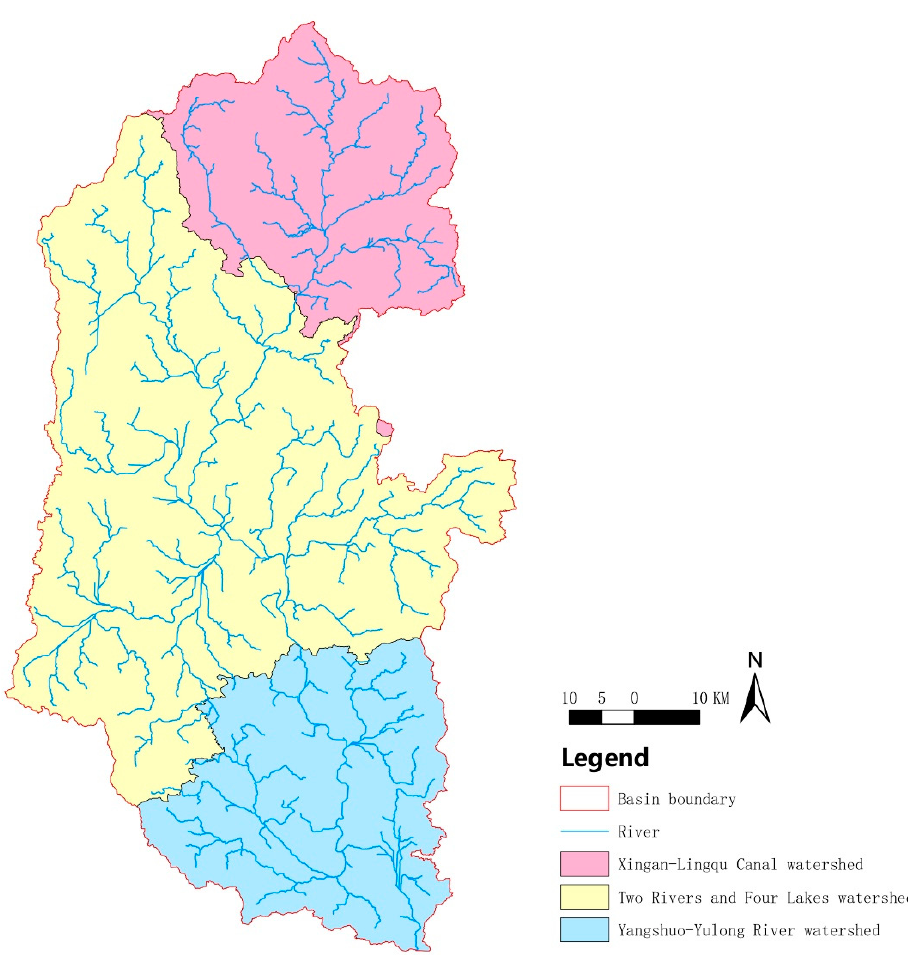
Figure 2. A diagram of the subdivisions of the Lijiang River Basin. The red area is the upstream basin (known locally as the Xing ‘an-Lingqu Canal watershed), the yellow area is the midstream basin (known locally as the two rivers and four lakes watershed), and the blue area is the down- stream basin (known locally as the Yangshuo-Yulong River watershed).